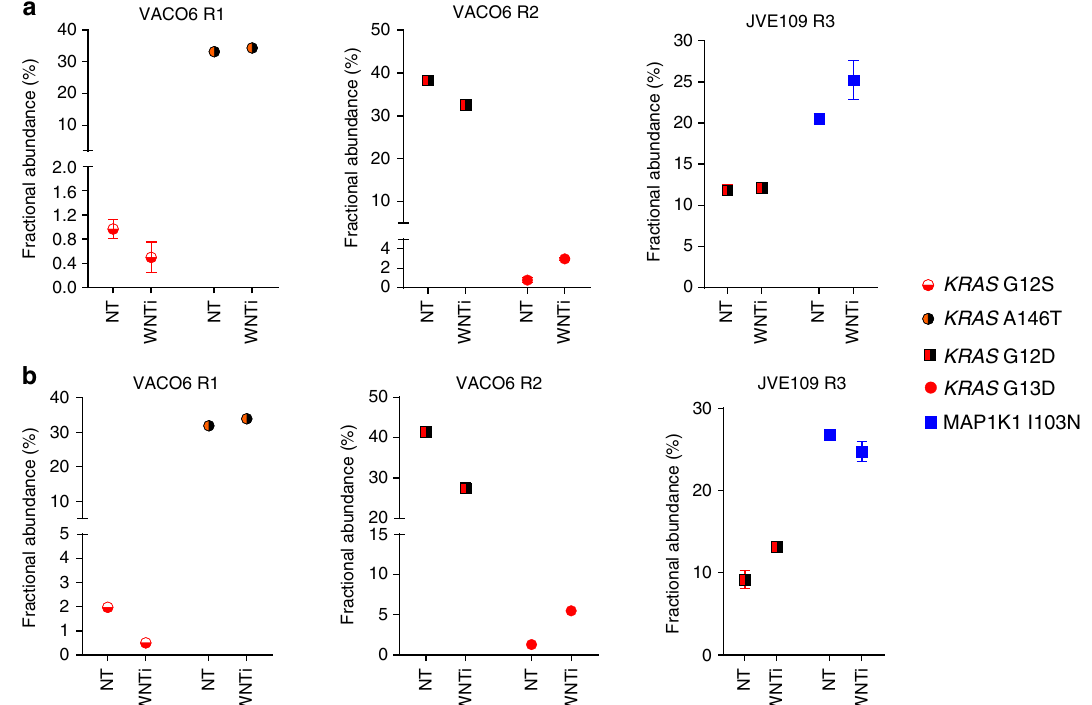
Fig. 6 Cell death associated with porcupine blockade is independent from MAPK alterations. MAPK-resistant CRC cells were treated with 1 µ M LGK974 (WNTi) for 2 weeks. After that, gDNA was extracted from the control untreated (NT) and the LKG974-treated cells. ddPCR analysis was performed to measure the fractional abundance of the mutated alleles, previously identi fi ed as mechanisms of secondary resistance to MAPK inhibition. Results represent means± SD of two independent technical replicates. a and b indicate the independent biological replicates of the